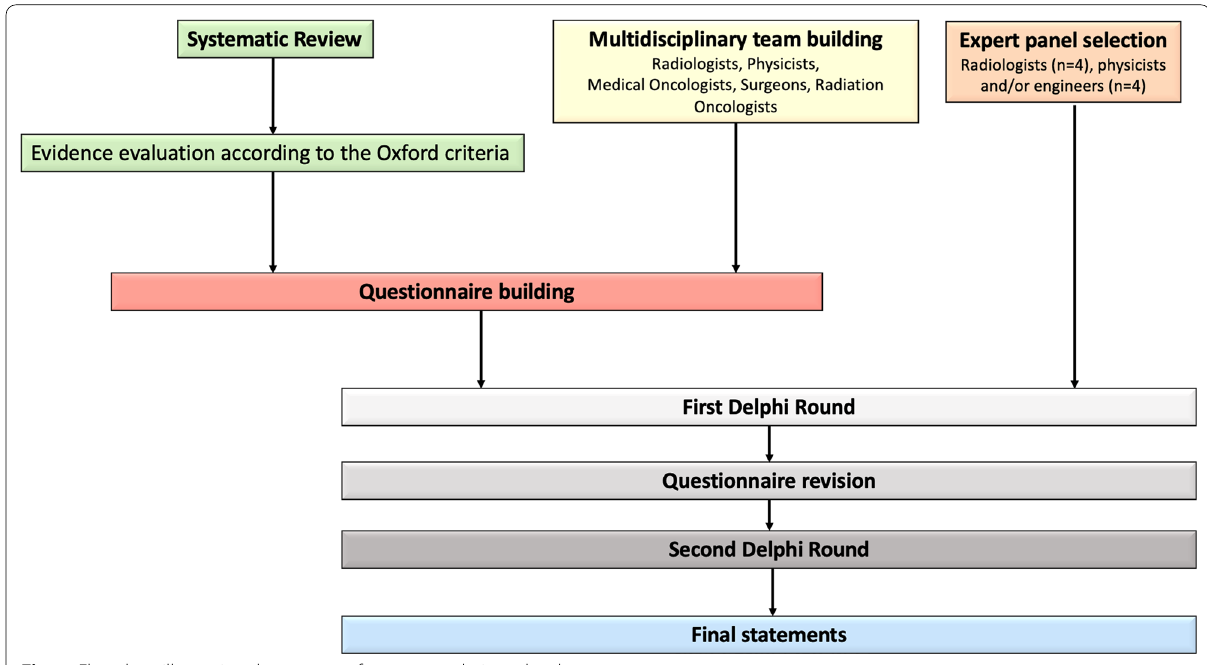
Fig. 1 Flowchart illustrating the process of recommendations